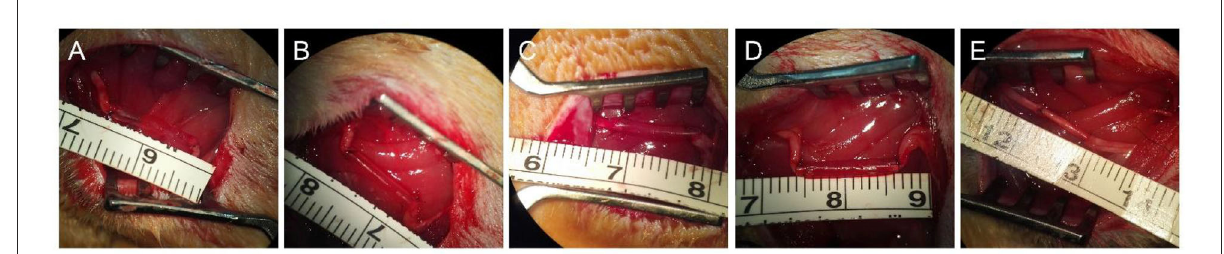
FIGURE3 Preparation and implantation of the nerve grafts of different groups. Gross morphologies of hollow chitosan nerve conduit group (Hollow, A ), chitosan nerve conduit filled with RAD/KLT nanofiber hydrogel (RAD/KLT, B ), RAD/IKVAV nanofiber hydrogel (RAD/IKVAV, C ) or RAD/KLT/IKVAV nanofiber hydrogel (RAD/KLT/IKVAV, D ) group, and autologous nerve graft group (Autograft, E ).